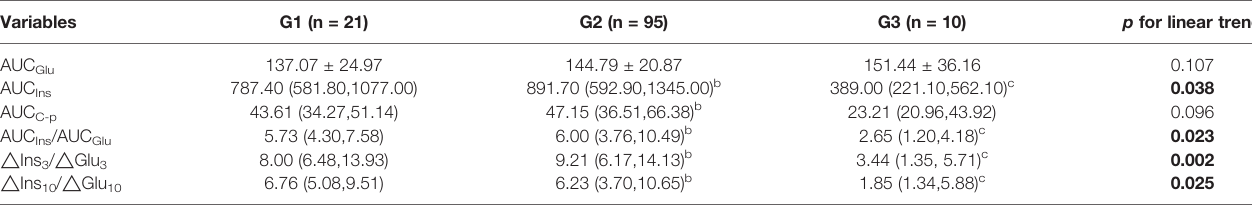
Data are presented as mean ± SD or as median (interquartile range). AUC, area under curve; Glu, plasma glucose; Ins, insulin; C-p, C-peptide; △ Ins y / △ Glu y = (Ins y − Ins 0 )/(Glu y − Glu 0 ), Ins y and Glu y represented insulin and glucose values, respectively, at time y min during the intravenous glucose tolerance test. a Difference between group 1 and group 2 was statistically signi fi cant(p 1 – 2 < 0.05). b Difference between group 2 and group 3 was statistically signi fi cant (p 2 – 3 < 0.05). c Difference between group 1 and group 3 was statistically signi fi cant (p 1 – 3 < 0.05). P values < 0.05 were shown in